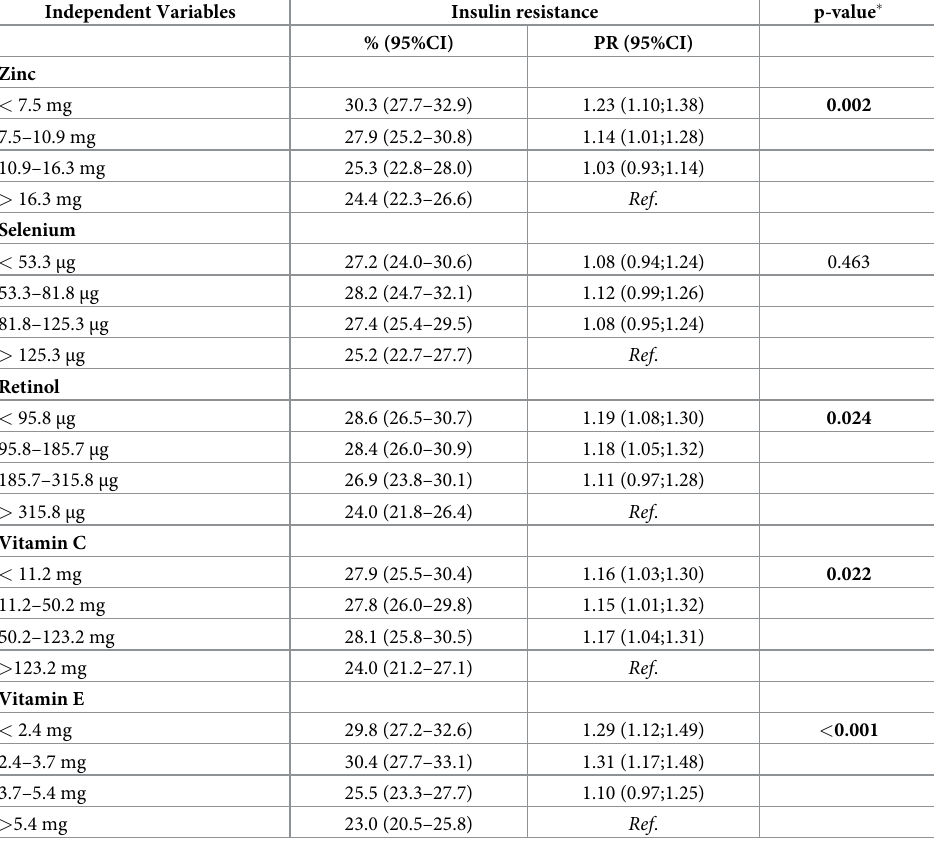
Table 5. Prevalence of insulin resistance, prevalence ratios, and confidence intervals according to antioxidant micronutrient intake by Brazilian adolescent students. ERICA Study,